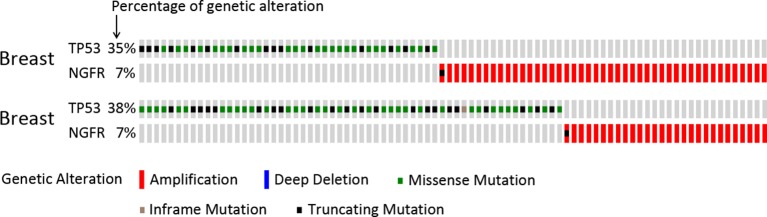
NGFR is apt to be amplified in breast cancers sustaining wild-type p53.TCGA database was searched and the data were modified from the cBioPortal for Cancer Genomics (http://www.cbioportal.org/; Gao et al., 2013; Cerami et al., 2012).